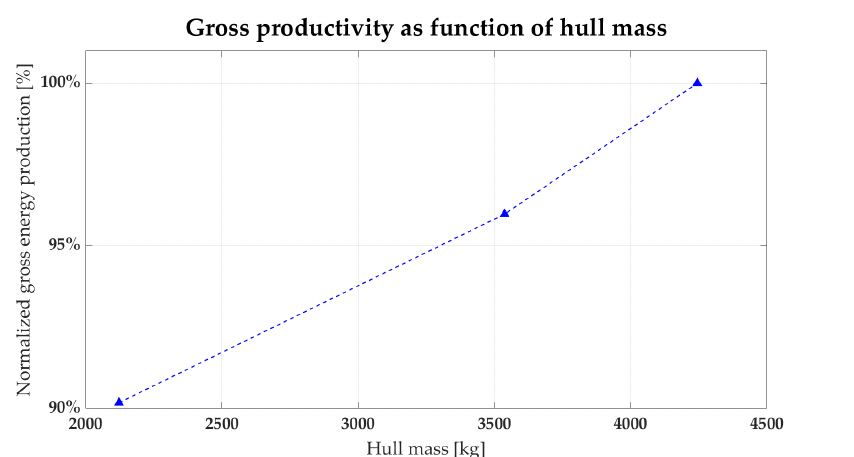
Figure 11. Gross productivity as function of hull